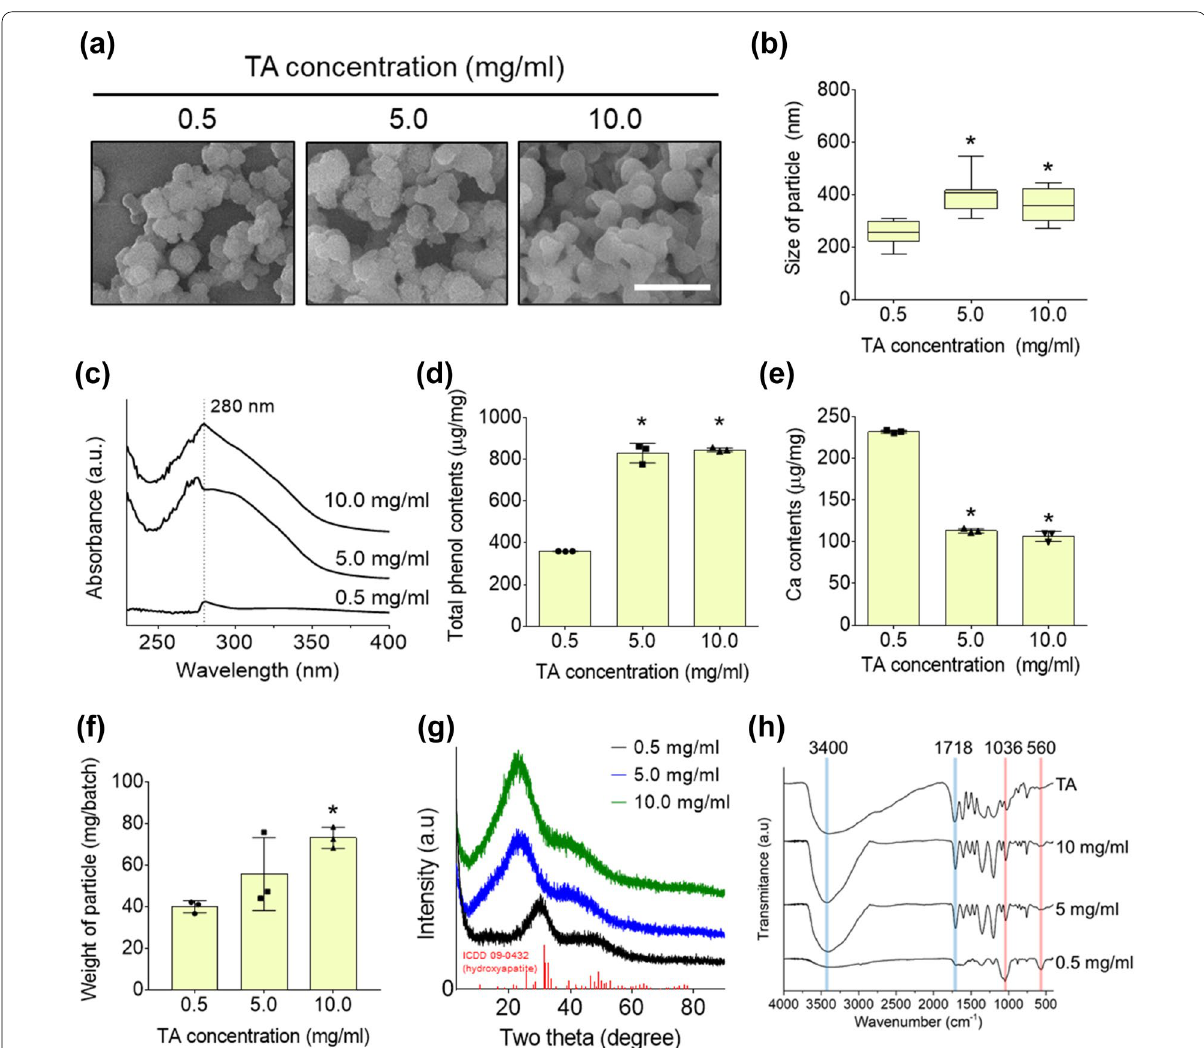
Fig. 1 a SEM images and b corresponding sizes of mTNs prepared at various concentrations of TA (scale bar compared to 0.5 mg/ml of TA ( p < 0.05). c Absorbance spectra of mTNs dispersed in DW. d Total phenol content and e calcium content of mTNs prepared with various concentrations of TA. Significantly different compared to 0.5 mg/ml ( p < 0.05). f Weight of mTNs prepared at various TA ∗ concentrations. Significantly different compared to 0.5 mg/ml ( p < 0.05). g XRD patterns of mTNs and commercially available hydroxyapatite. h ∗ FT‑IR analysis of TA and